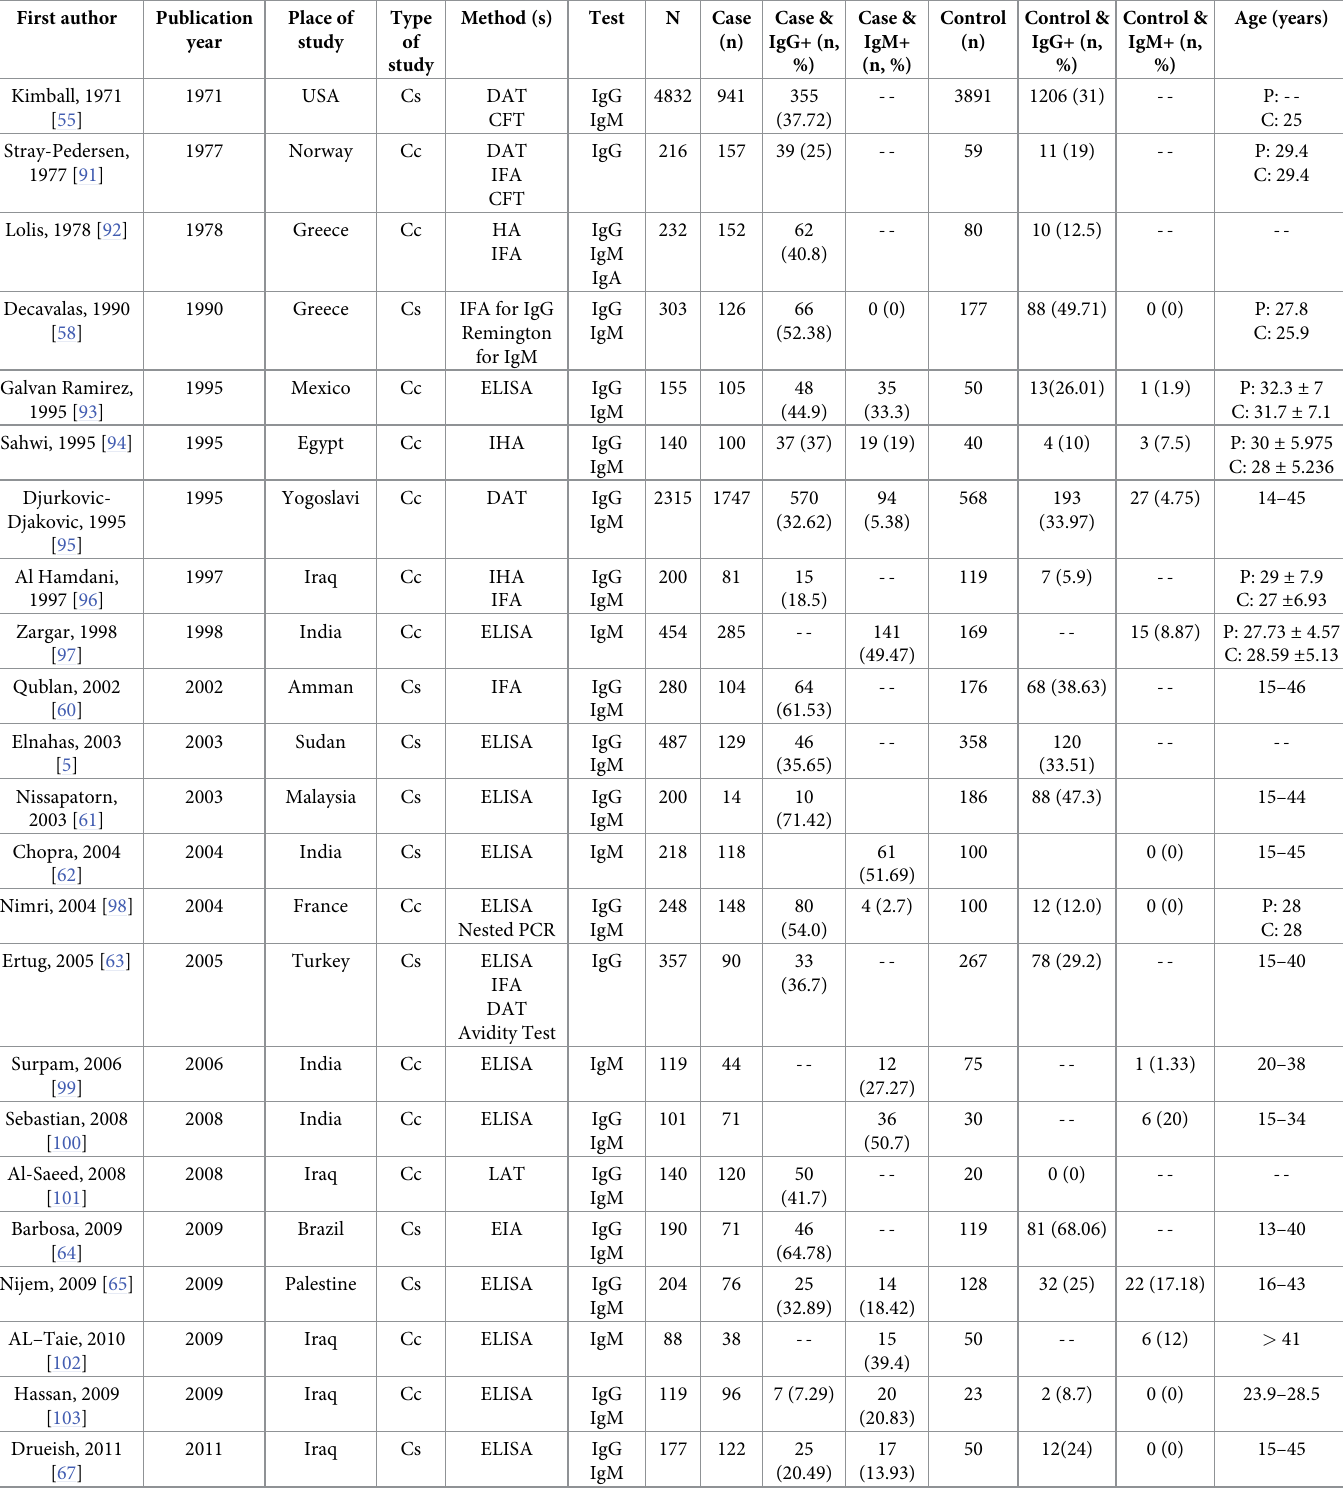
Table 3. Description of the studies included looking for an association between seroprevalence of anti- T . gondii antibodies and